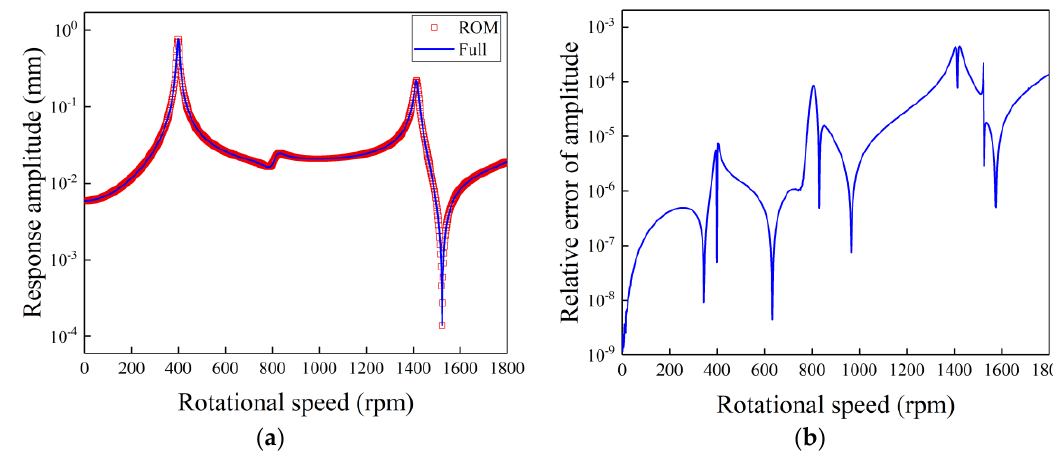
Figure 3. The gravity response amplitude and the relative error of reduced-order model (ROM) versus rotational speed: ( a ) gravity response amplitude; ( b ) relative error.